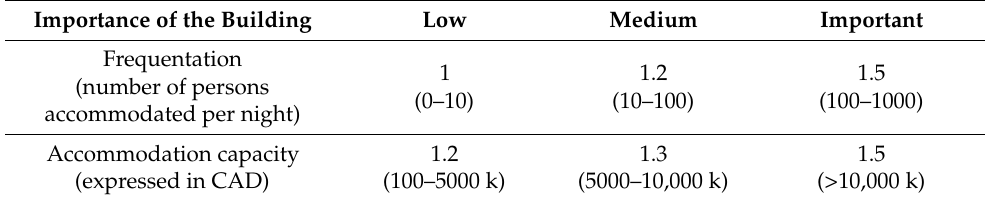
Table 7. Matrix used to determine criterion F (adapted from NRC1992 and NBCC2005). Importance of the Building